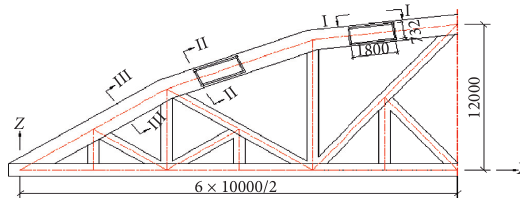
Figure 1: Elevation of 1/2 of the main truss (unit: mm).